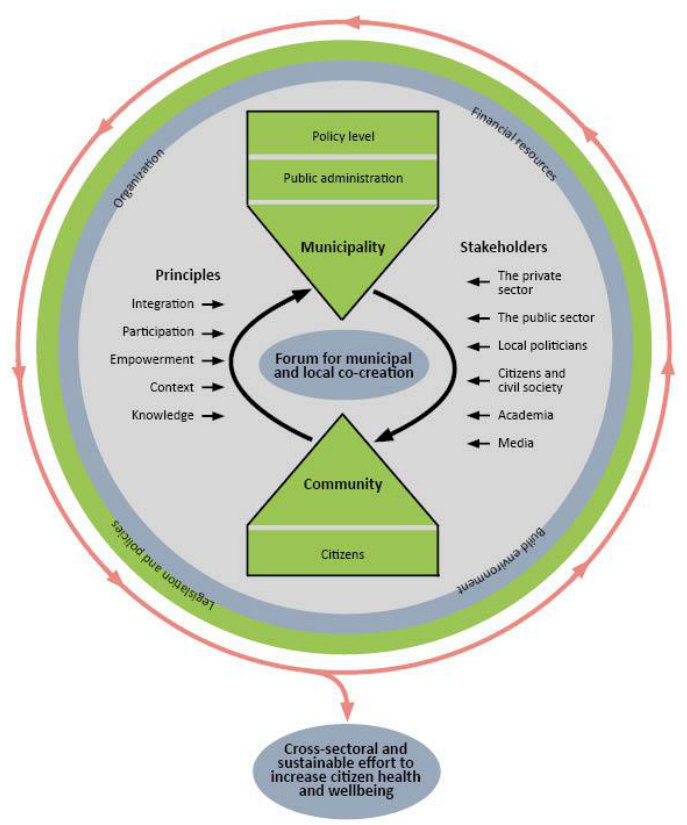
Figure 1. Conceptual framework of the OHC model for prevention and health promotion at municipality level.